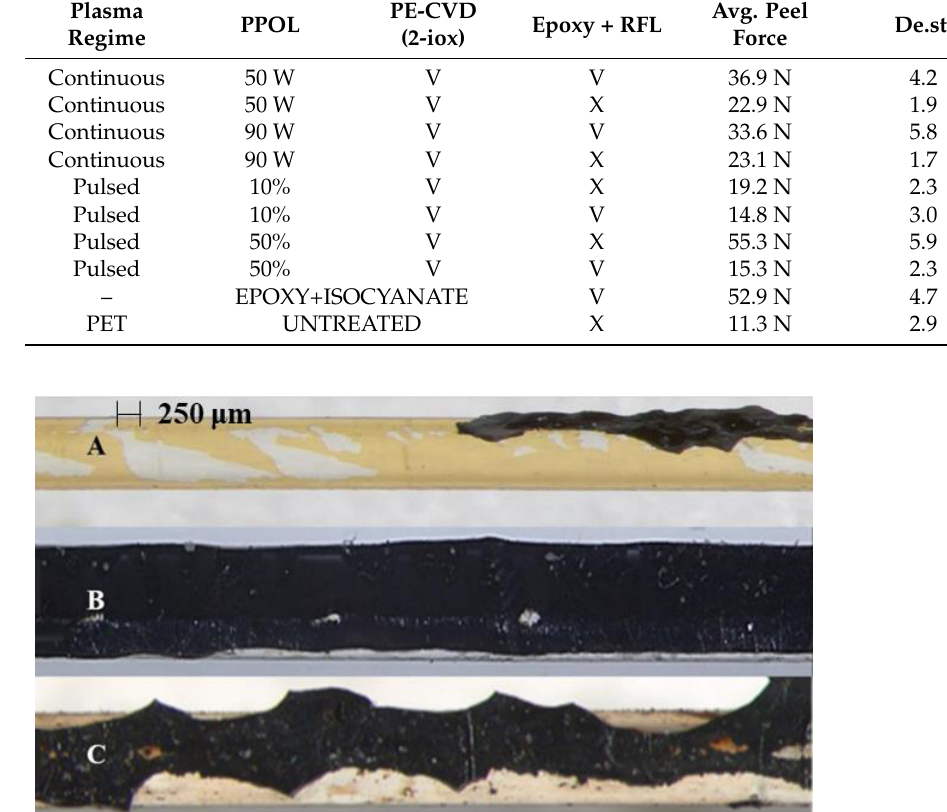
Figure 6. TEM images of activated 2-iox PPOL ( A ) and Epoxy + RFL adhesive ( B ). Thickness is 1.1. μm for the PPOLs and between 1.7 and 2.8 μm for the Epoxy + RFL. 4. Conclusion The aim of the work was to find an environmentally friendly method, as an alterna- tive to the classical method (epoxy bath + RFL), to guarantee the adhesion between PET monofilament and rubber compounds. Two different regimes of plasma (continuous and pulsed) were used to perform a PE-CVD of 2-isopropenyl-2-oxazoline. The PPOLs were deposited at different powers and duty cycles, while the treatment time and flow of Argon and 2-iox were kept constant. The surface characterizations were carried out on PET sheets. The c.a. measurement highlighted how the fragmentation happens even at low power (20 W) but does not occur at low duty cycle (10% d.c.). In this condition, the oxa- zoline rings were retained. The characterizations with ATR-IR and XPS confirmed the c.a. analyses, indicating that, in the 10% d.c. PPOL, the characteristic peaks of the monomer are recognizable. The PPOLs were tested, both as adhesives and pre-dips for the RFL, by a peel test. The result of the adhesion test highlighted how the PPOL, obtained in the pulsed regime at 50% duty cycle, has comparable peel force to that of the chemical dip. The PE-CVD in the pulsed regime was probably more controlled than the treatment in the